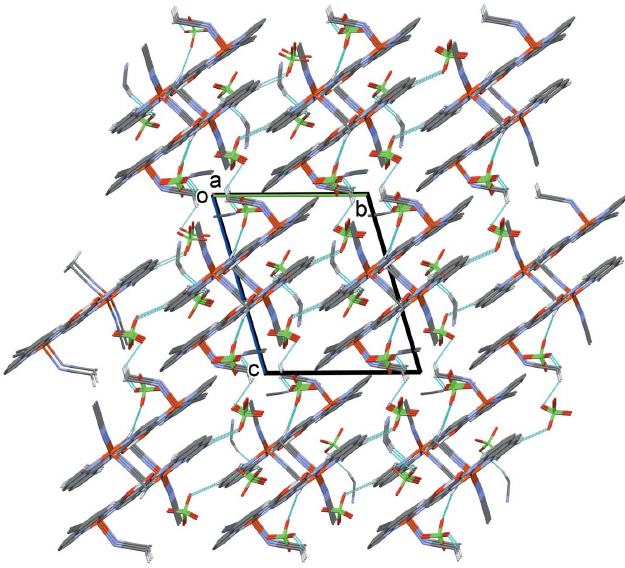
Figure 6 The crystal packing of complex I , viewed along the a axis. Hydrogen bonds are shown as dashed lines (see Table 4). In the crystal of complex I , the cations are arranged in layers parallel to the (012) plane. They are linked via the (Table 4), so forming a supramolecular three-dimensional